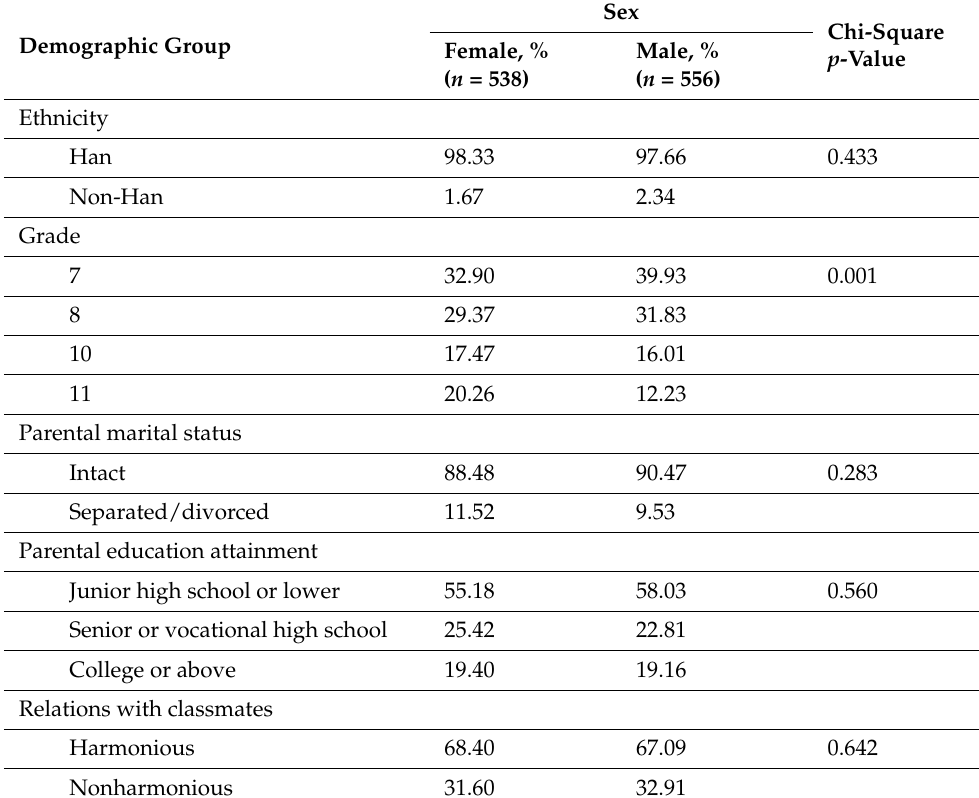
Table 2. Demographic characteristics of all respondents by